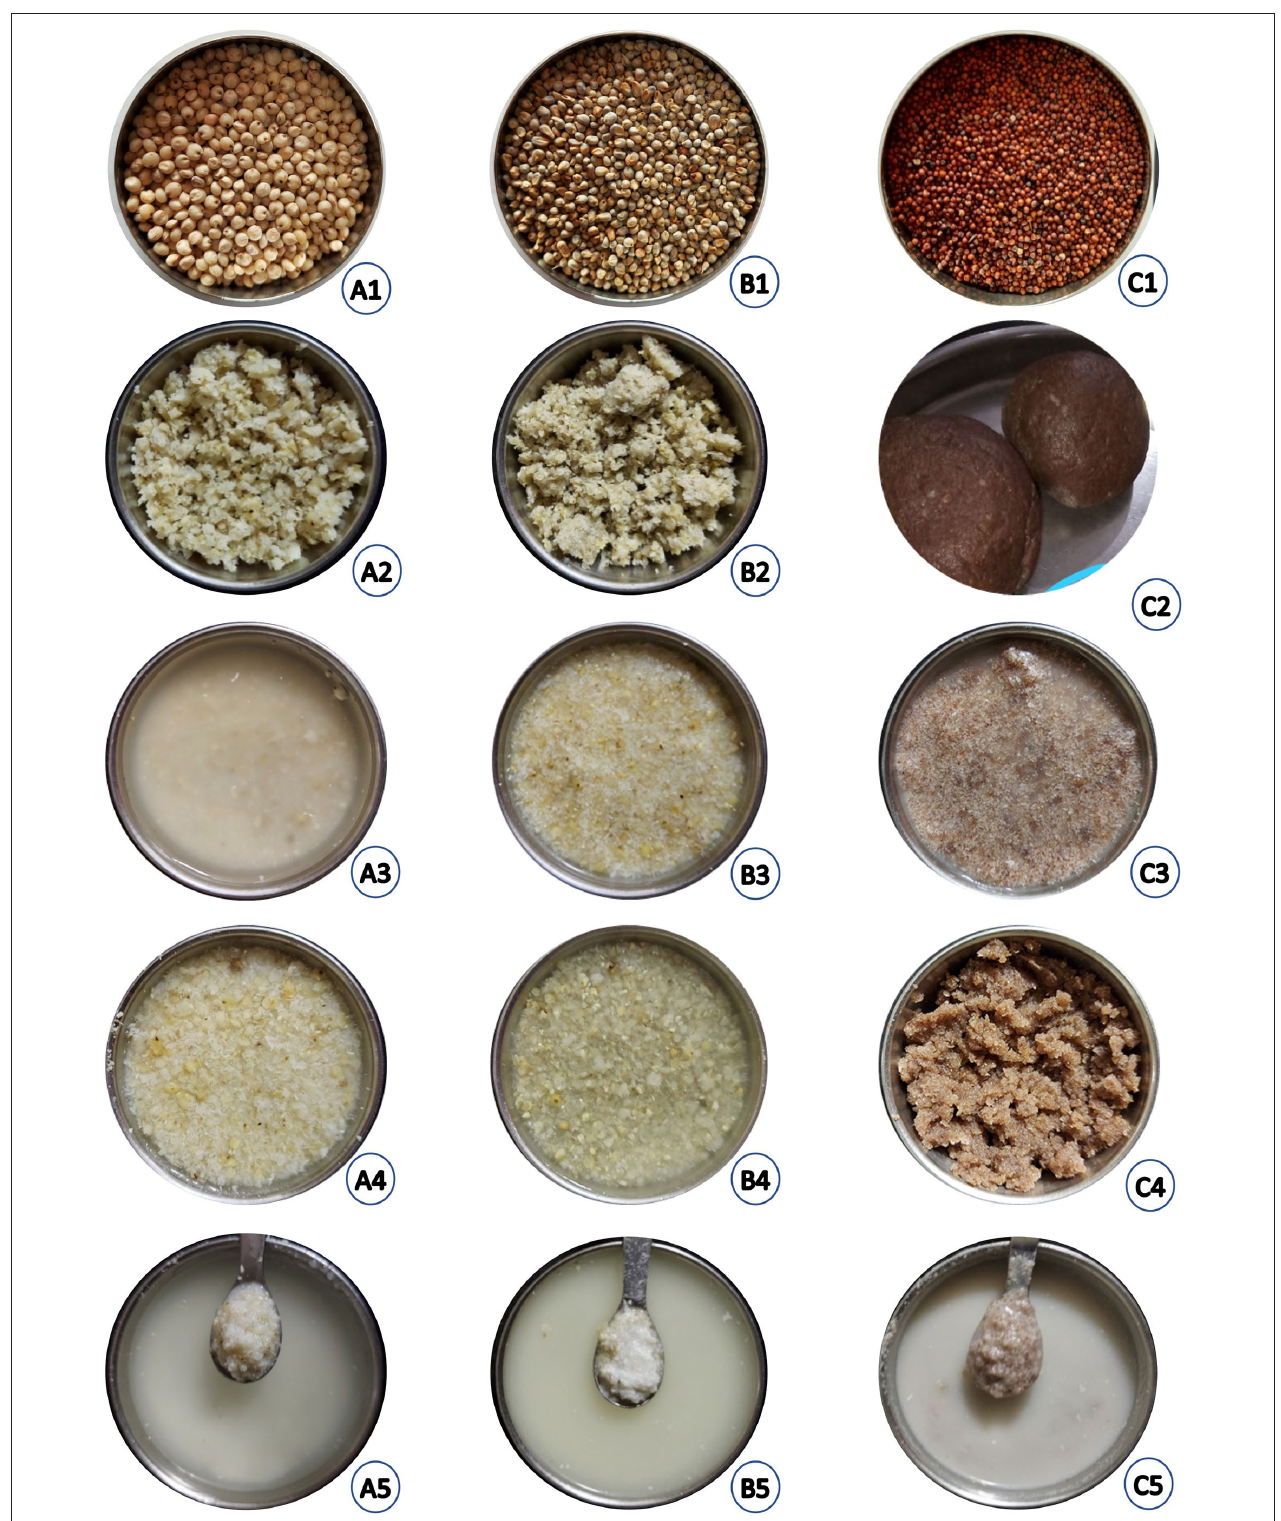
FIGURE 2 | Raw, cooked, and fermented millet foods. (A1–A5) : Sorghum ( A1 —raw, A2 —cooked, A3 —cooked and fermented with curd overnight, A4 —cooked and fermented with water overnight, A5 —cooked and fermented with water overnight and added with curd). (B1–B5) : Pearl millet ( B1 —raw, B2 —cooked, B3 —cooked and fermented with curd overnight, B4 —cooked and fermented with water overnight, B5 —cooked and fermented with water overnight and added with curd). (C1–C5) : Finger millet ( C1 —raw, C2 —cooked, C3 —cooked and fermented with curd overnight, C4 —cooked and fermented with water overnight, C5 —cooked and fermented with water overnight and added with